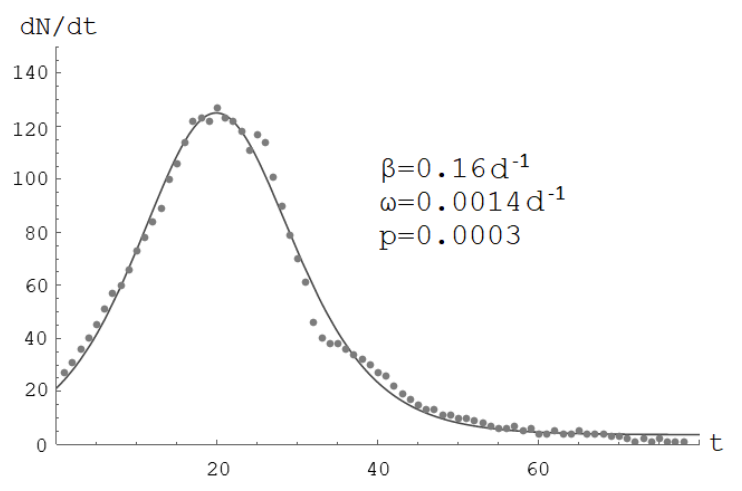
Figure 4. Daily deaths in the COVID-19 epidemic in China versus time (dots) and model dependence (solid line)